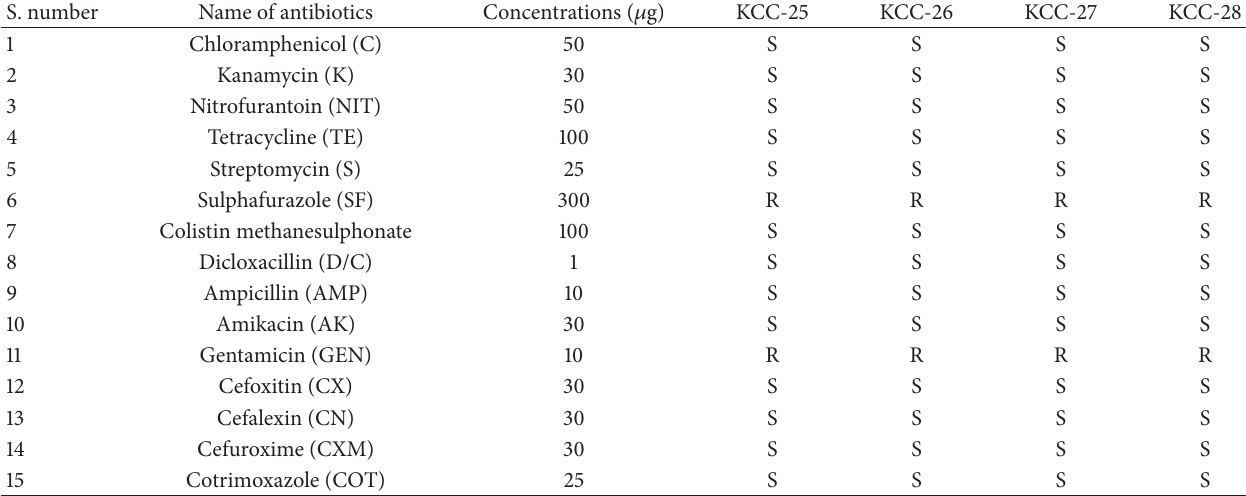
Table 2: Antibiotic sensitivity of Lactobacillus plantarum .